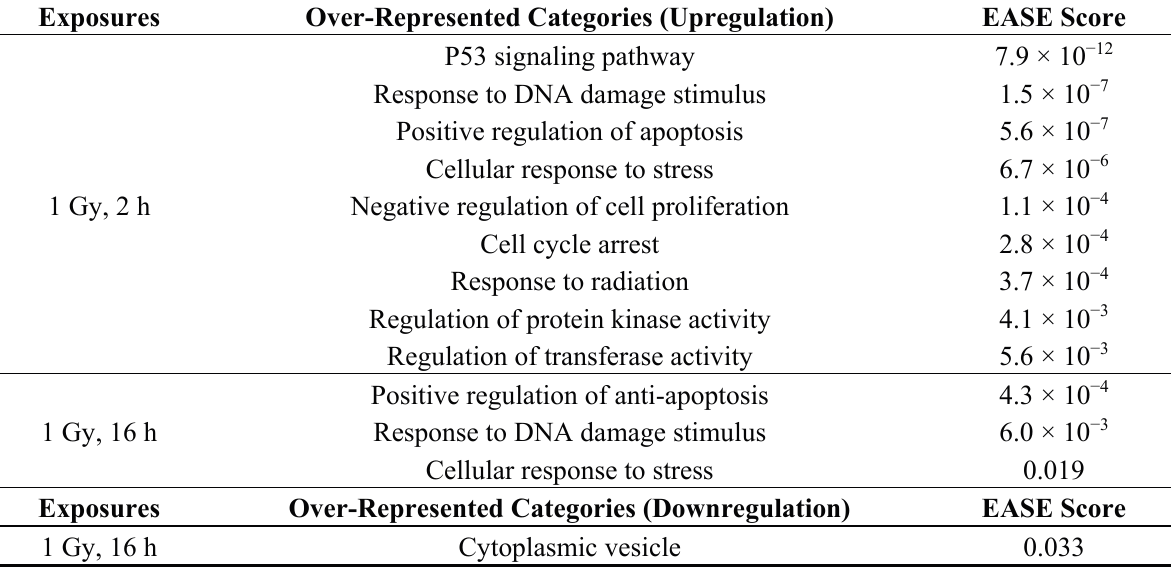
Table 1. Gene Ontology analysis of affected biological processes/pathways/themes in hESCs after HDIR based on consensus sets of genes found in all lines of hESC